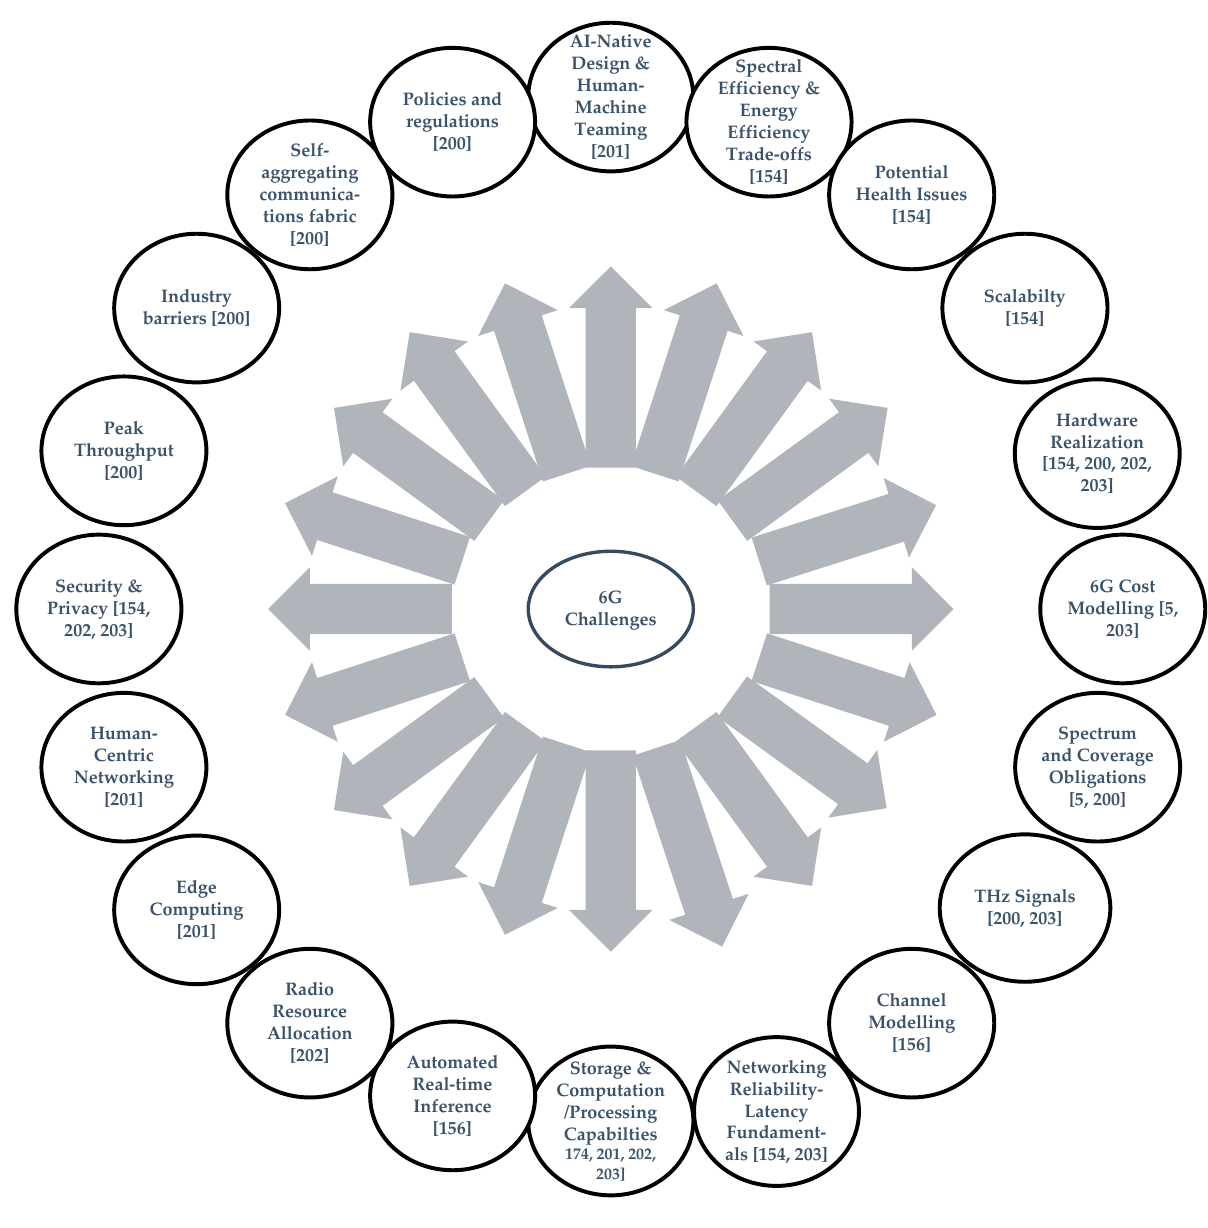
Figure 6. Challenges of 6G